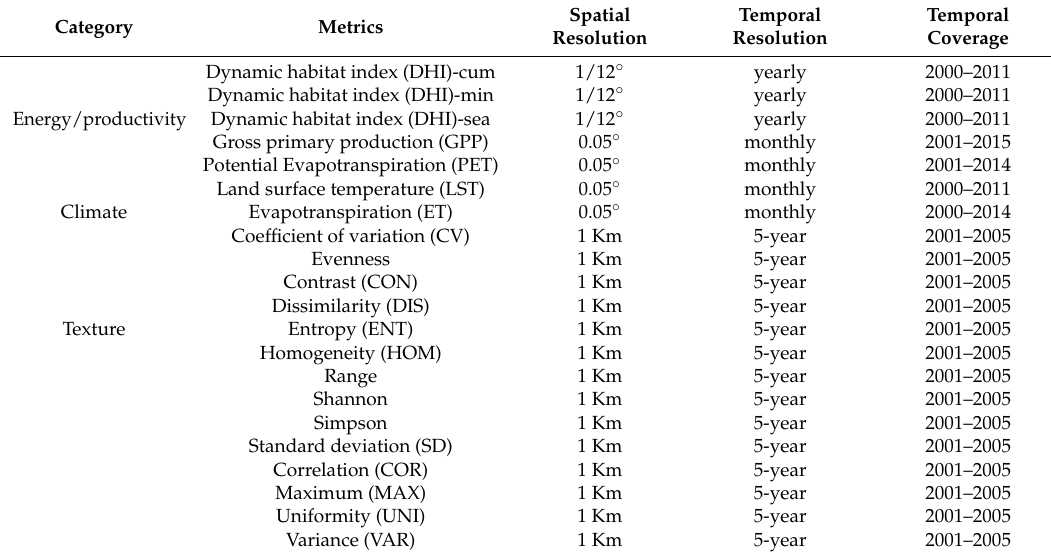
Table 1. Remote sensing